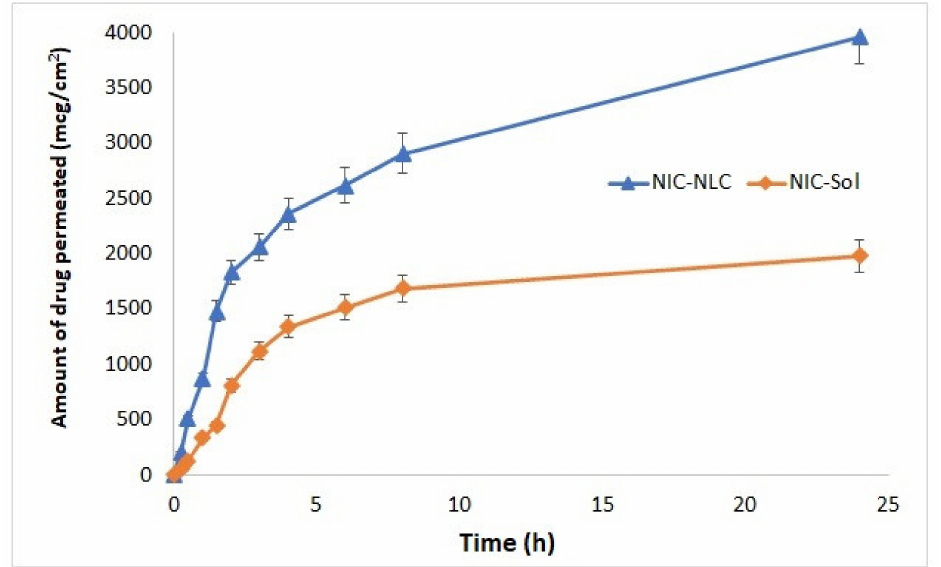
Figure 7. Ex vivo permeation profiles of the optimized NIC–NLC formula compared to NIC–SOL through sheep nasal mucosal